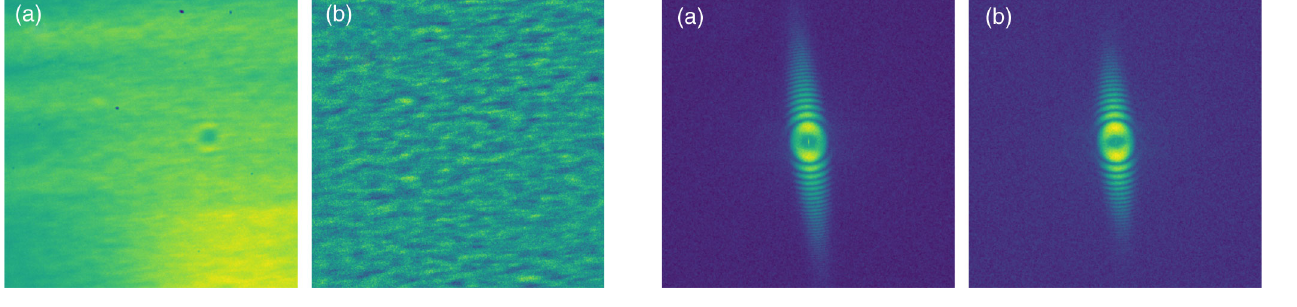
FIG. 9. 2D power spectra at κ ¼ 0 . 50% (a) and κ ¼ 2 . 80% (b). Data refer to z ¼ 1 . 1